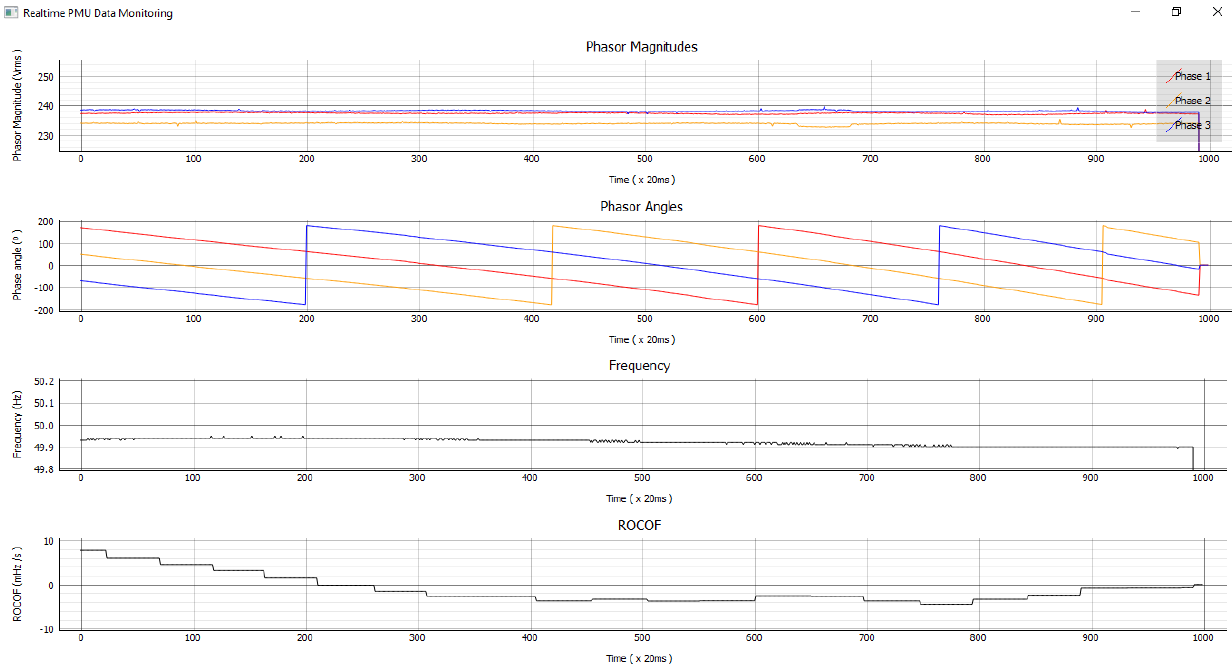
Figure 28. External monitoring